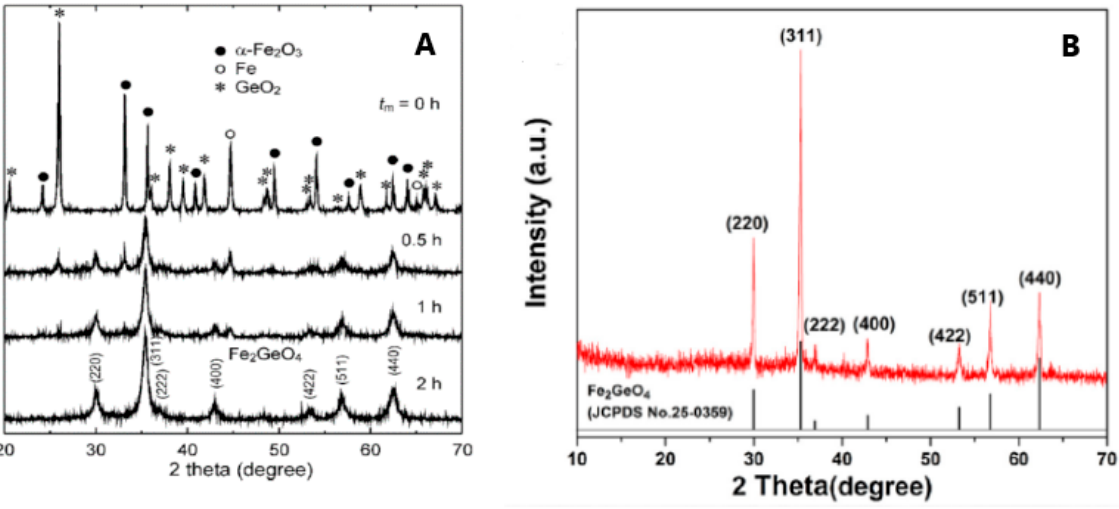
Figure 4. ( A ) XRD patterns of the GFO samples obtained by mechano-chemical synthesis at different mixing times [27], Reproduced with permission, Copyright De Gruyter 2008; ( B ) 3D GFO/N-CNSs XRD pattern [31], Reproduced with permission, Copyright Elsevier 2018. Table 1. The main synthesis methods of GFO reported up to now in the literature and described in the